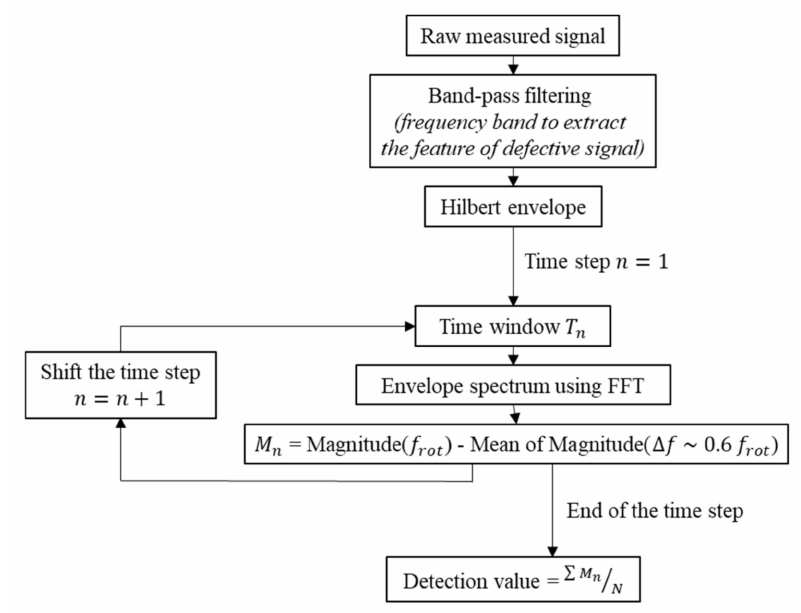
Figure 10. Flowchart for proposed